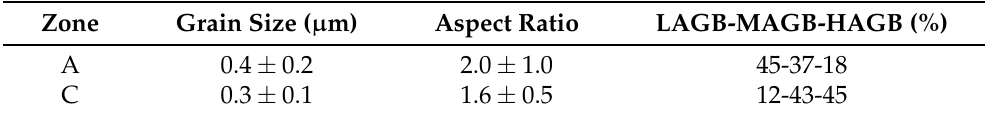
Figure 11. T = 20 ◦ C N cycle = 500 with τ min / τ max = 100/560 MPa, γ final = 3.5. IPF X map of − the microstructural gradient of the cracked zone that corresponds to the white box in Figure 10 for the case at room temperature, stepsize = 0.06 µ m. This region is divided into four areas: zone A is composed of fibered and fragmented grains (stage 3). Zone B is a WEL area with very small grains and disoriented grains. Zone C is composed of very small and disoriented grains (stage 4), whereas zone D is a transition area with grains that begin to fiber and fragment themselves (stage 2 and 3). Table 7. Summary of measurements of indicators for the EBSD map in Figure